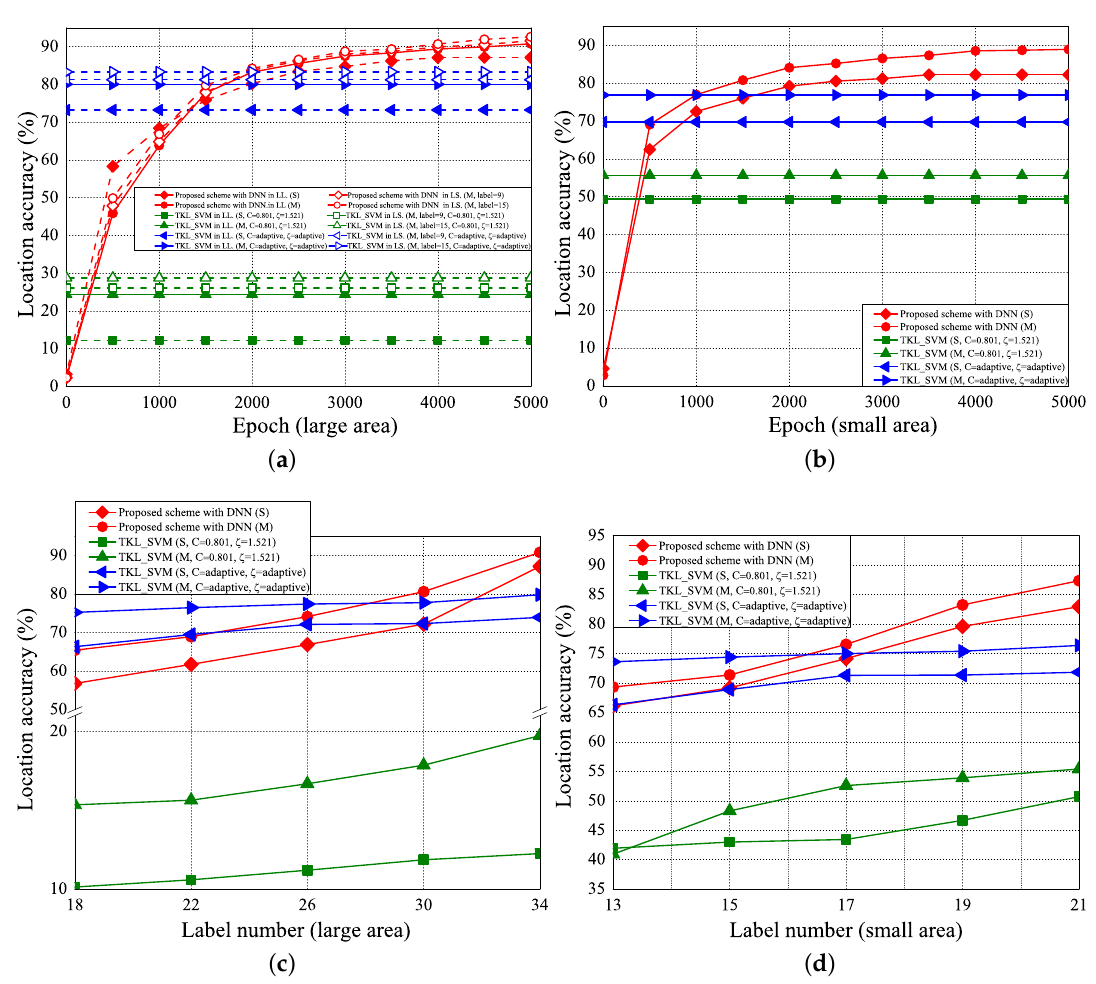
Figure 14. ( a ) Location accuracy (LL,LS) vs. per epoch; ( b ) location accuracy (SS) vs. per epoch; ( c ) location accuracy (LL,LS) vs. number of labelled samples; ( d ) location accuracy (SS) vs. number of labelled